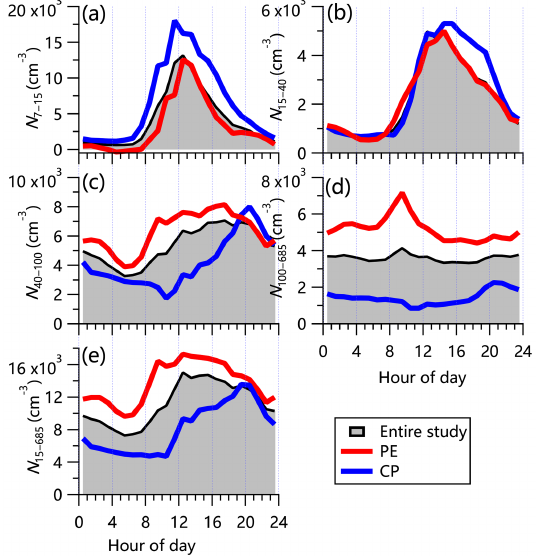
Figure 7. Diurnal cycles of particle number concentration for (a) N 7–15 calculated from the differences between MCPC and SMPS measurements, (b) N 15–40 (15–40nm), (c) N 40–100 (40– 100nm), (d) N 100–685 (100–685 nm), and (e) all particles, N 15–685 (15–685nm). Overall mean cycles are shown as black lines. Mean cycles for polluted events (PEs) and clear periods (CPs) are shown as red and blues lines, respectively.